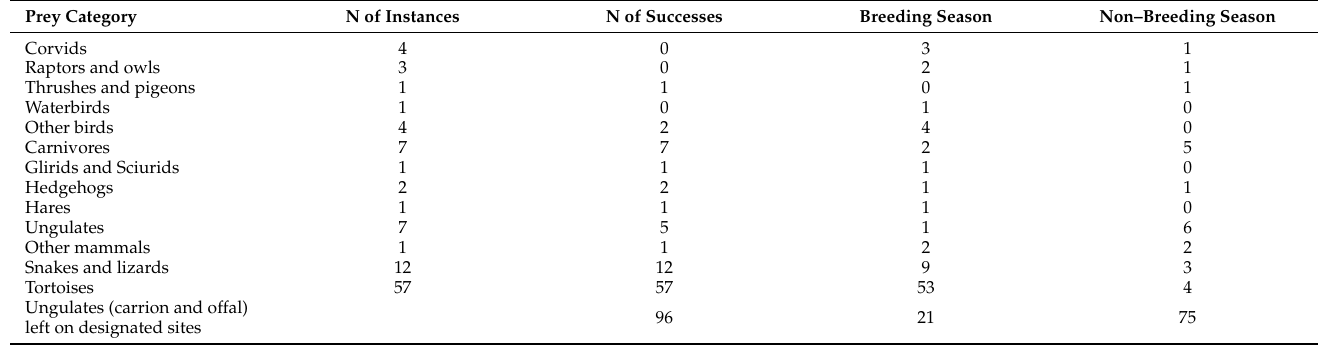
Table A2. Summary of the observation dataset. N of instances refers to all behavioral interactions including unsuccessful attacks, N of successes to instances where eagles were seen successfully capturing prey or feeding in prey already captured or